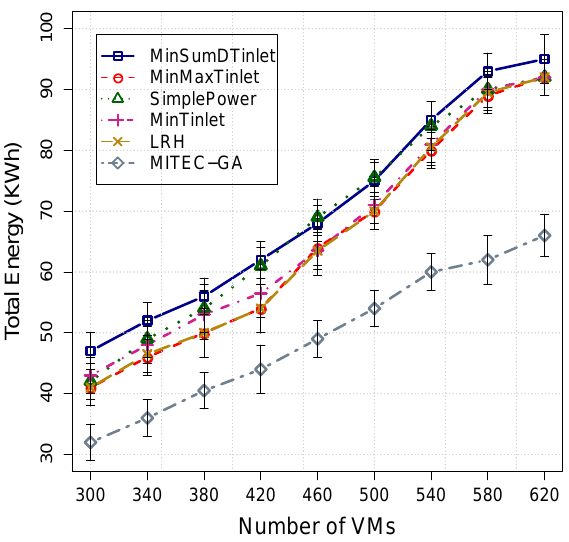
Figure 2. Total energy consumption vs. Virtual Machine (VM) numbers. MITEC-GA: minimizing the total energy consumption of a heterogeneous data center–genetic algorithm.